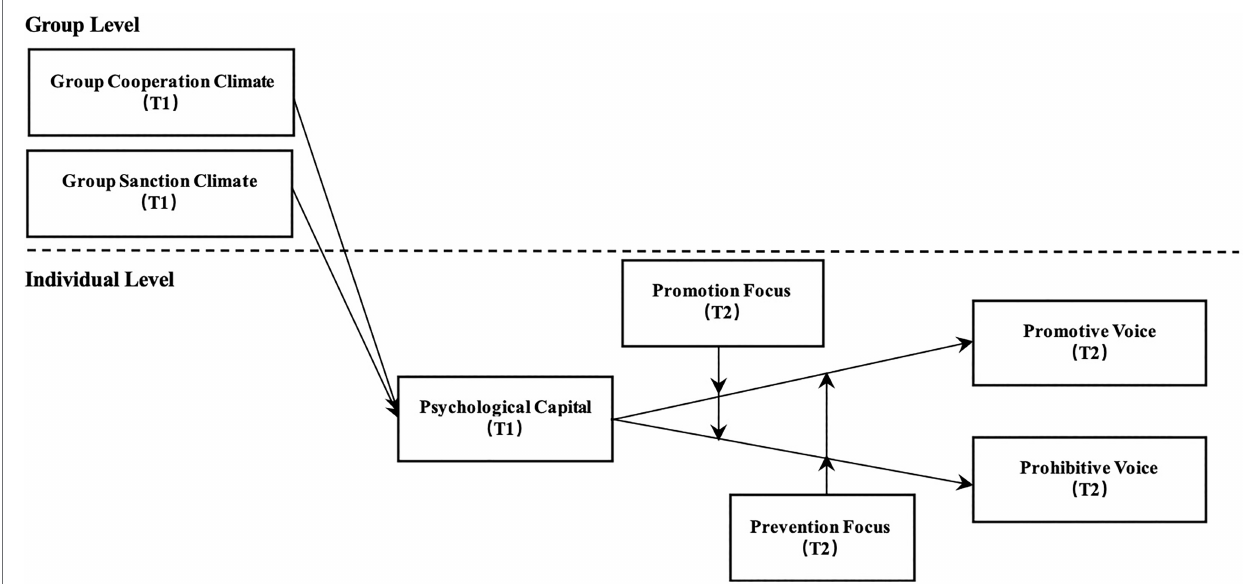
FIGURE 1 | A cross-level mediation model of group climates on employee